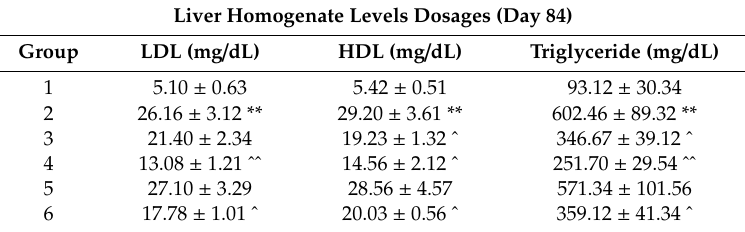
Table 6. E ff ects of HFD and AP-NHm mixture on cholesterol and triglyceride concentrations in liver homogenate on Day 84.